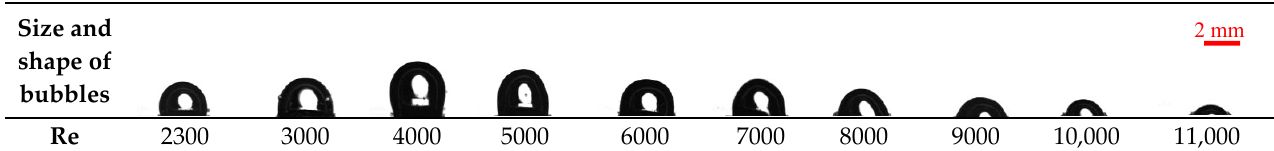
Figure 18. The changing law of bubble aspect ratio.